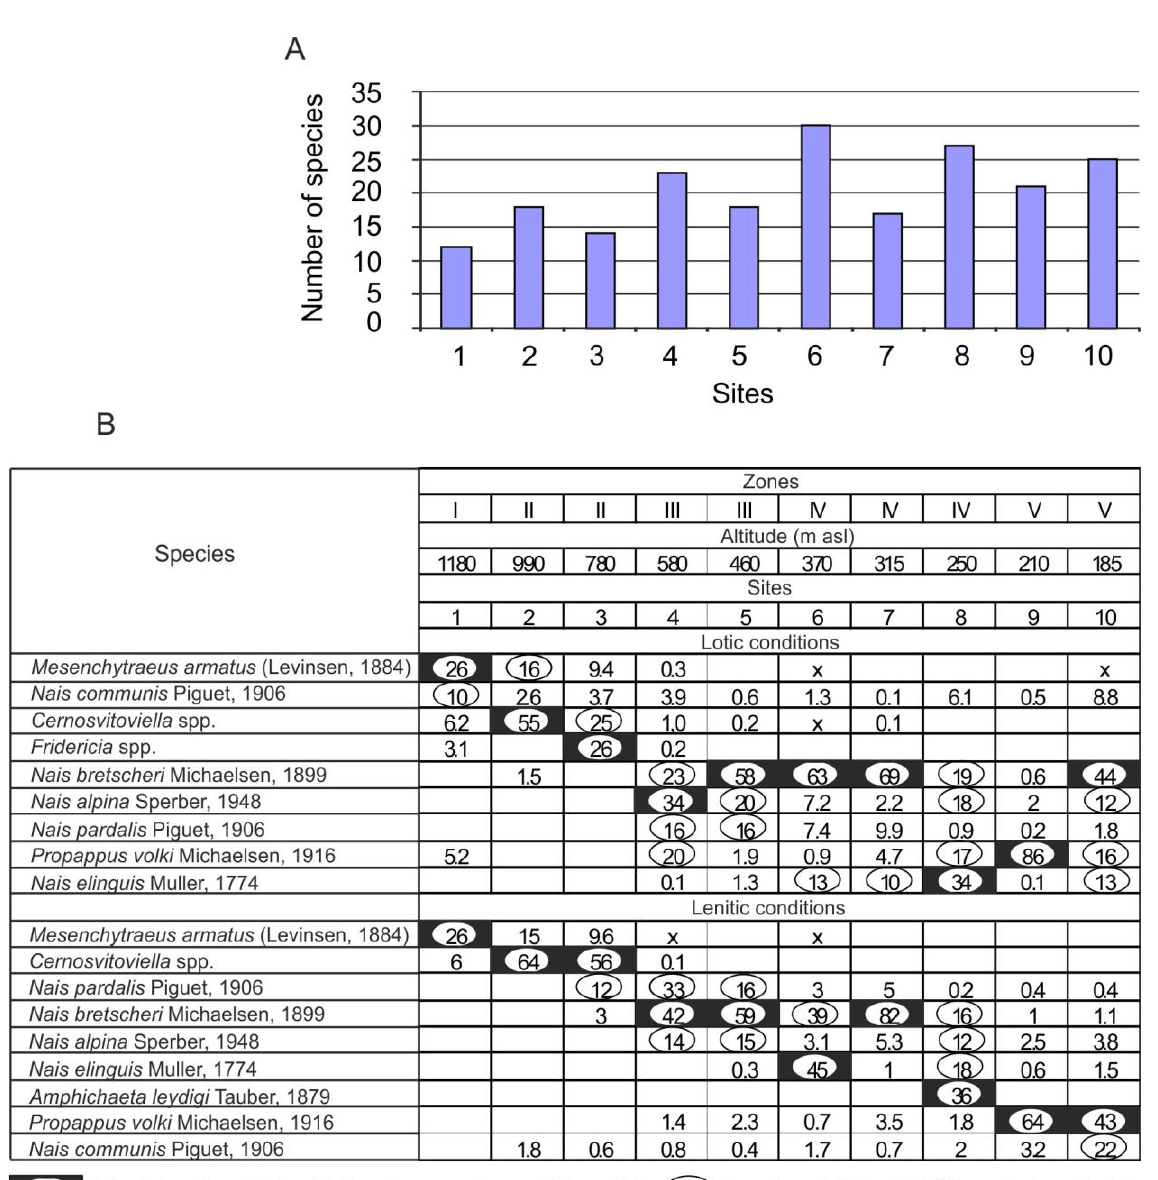
Figure 3. The number of species ( A ) and percentage of dominant species ( B ) of Oligochaeta in the Raba River in lotic and lenitic conditions in 1969–1970 (according to [17], modified).